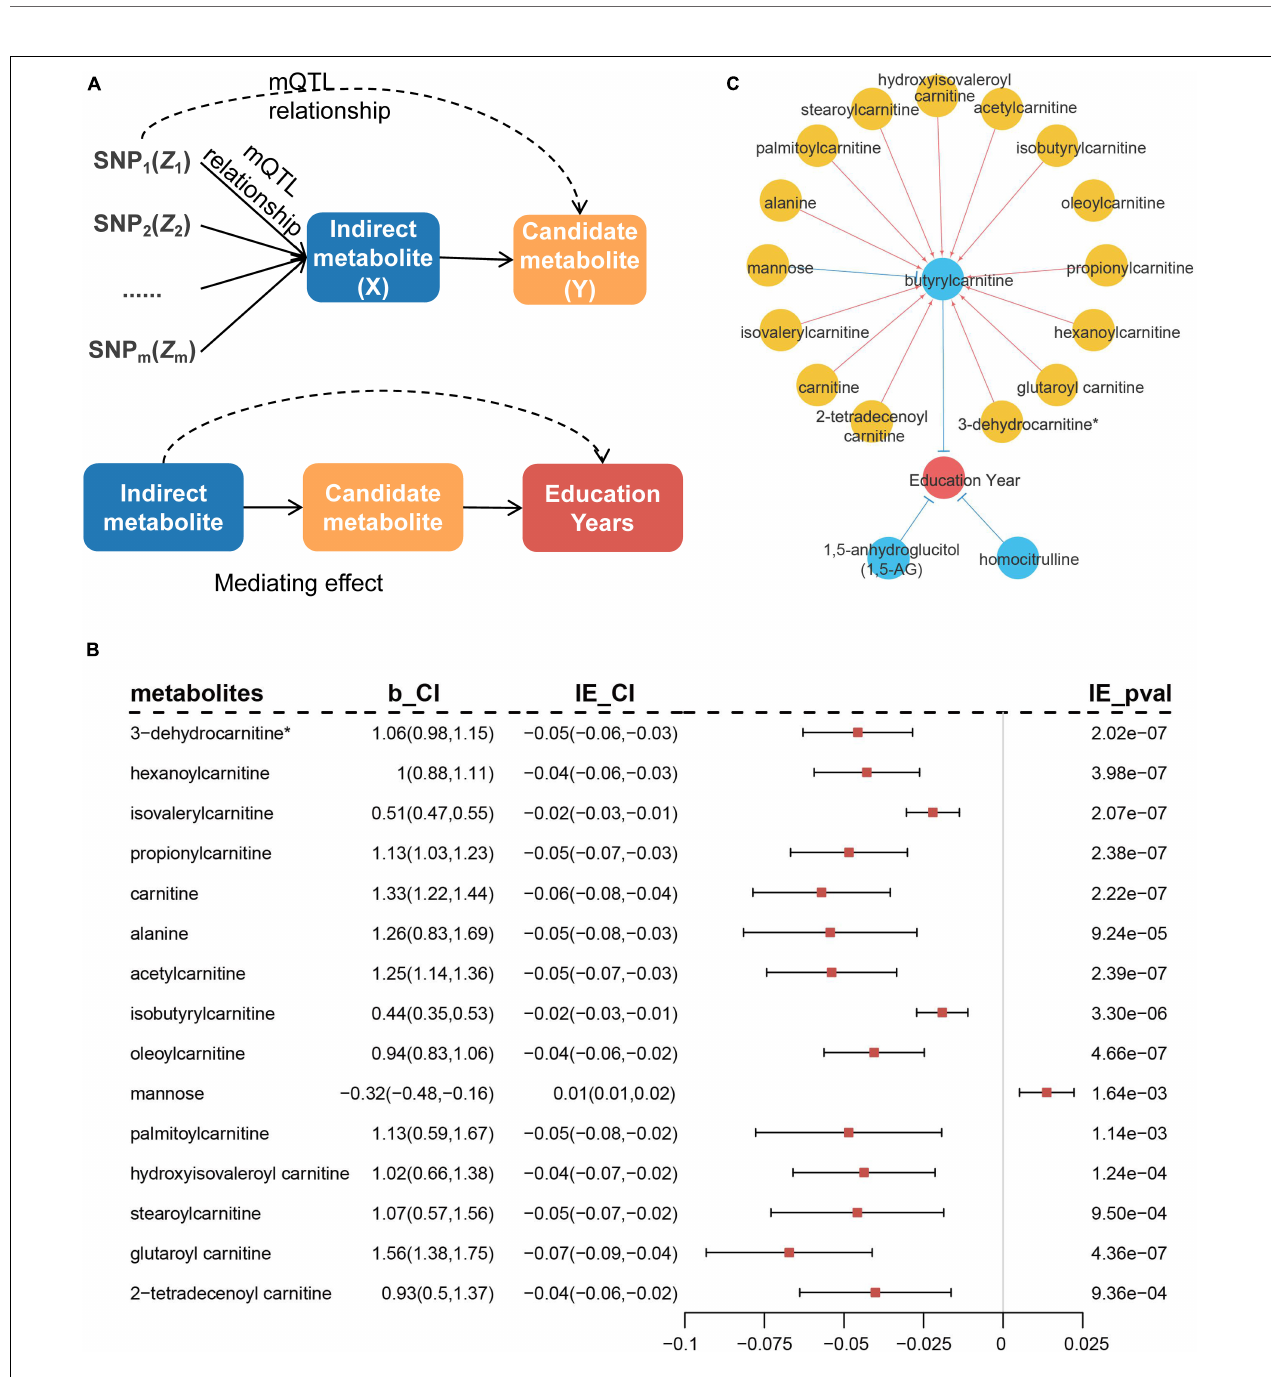
FIGURE 7 | Diagram of MR analysis between metabolites and mediation analysis. (A) MR inferring the causal association of remaining metabolites ( X ) on previously identified metabolites ( Y ). Mediation analysis of the rest of metabolites on risk of education years through the identified metabolites. (B) Metabolites that indirectly mediate the effect on education years through butyrylcarnitine in mediation analysis. b_CI represents effect of metabolites on butyrylcarnitine and 95% confidence interval (95% CI). IE_CI represents indirect effect of metabolites on education years and 95% CI, and IE_pval represents P -values. (C) Causal network of blood metabolites on education years. Blue circles indicate metabolites that are directly identified, while yellow circles have indirect effect through blue metabolites. Red lines represent positive effects, and blue lines indicate negative effects.